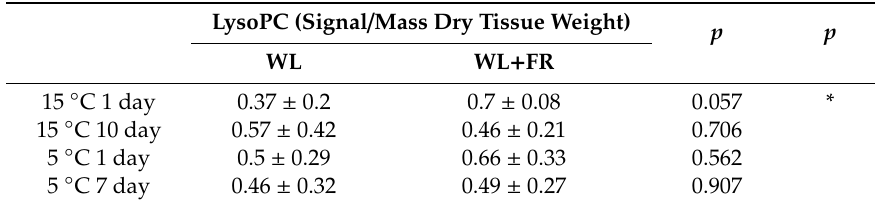
Table 5. LysoPC in barley leaves grown at 15 ◦ C for 1 and 10 days and in leaves grown at 5 ◦ C for 1 and 7 days under WL and WL + FR.